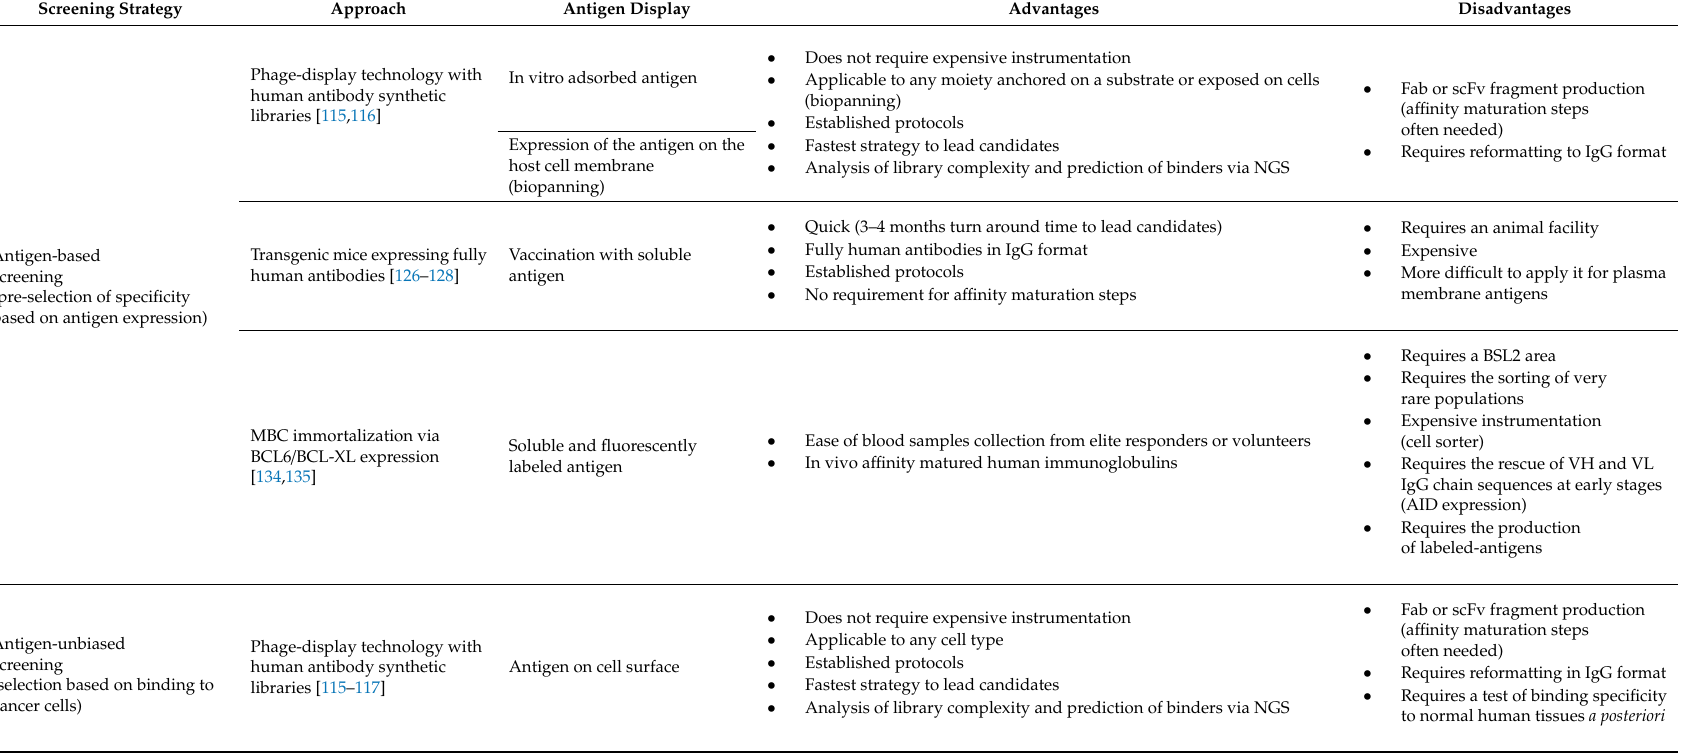
Table 1. Advantages and drawbacks for all screening strategies used to obtain fully human